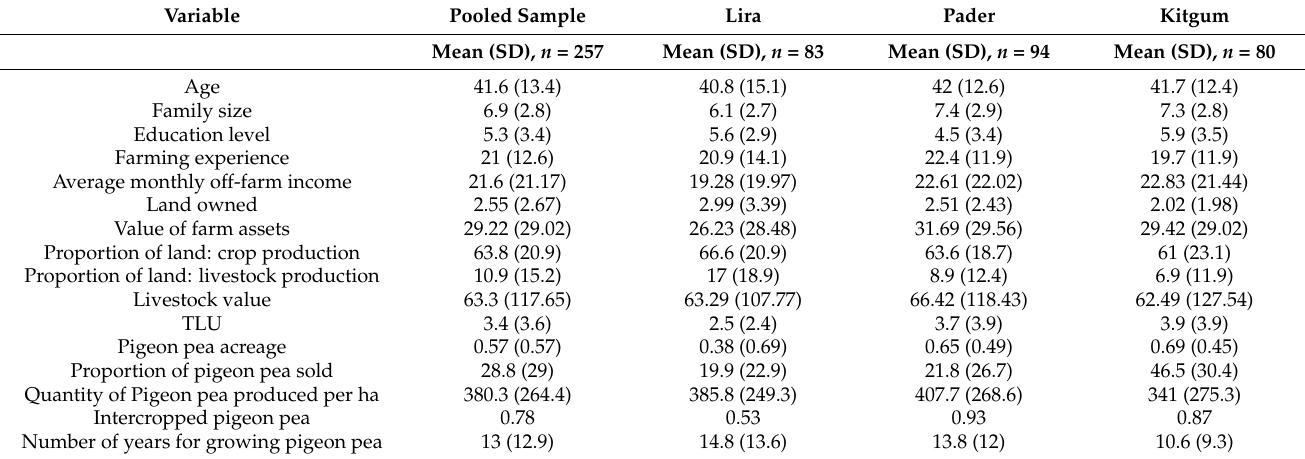
Source: Survey data 2019. Means and standard deviation presented. SD is standard deviation. Note: Tropical Livestock Unit (TLU) conversion: cattle = 1; goats, sheep, and pigs = 0.1; donkeys = 0.5; oxen = 1.42; chickens, turkeys, ducks, and guinea fowl = 0.01; rabbits = 0.02 (Jahnke,